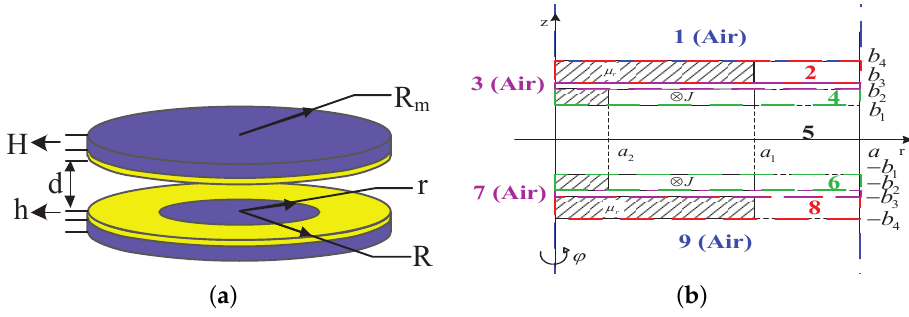
Figure 4. Central bulge ferrite core: ( a ) Schematic diagram and structure parameters; ( b ) Transverse